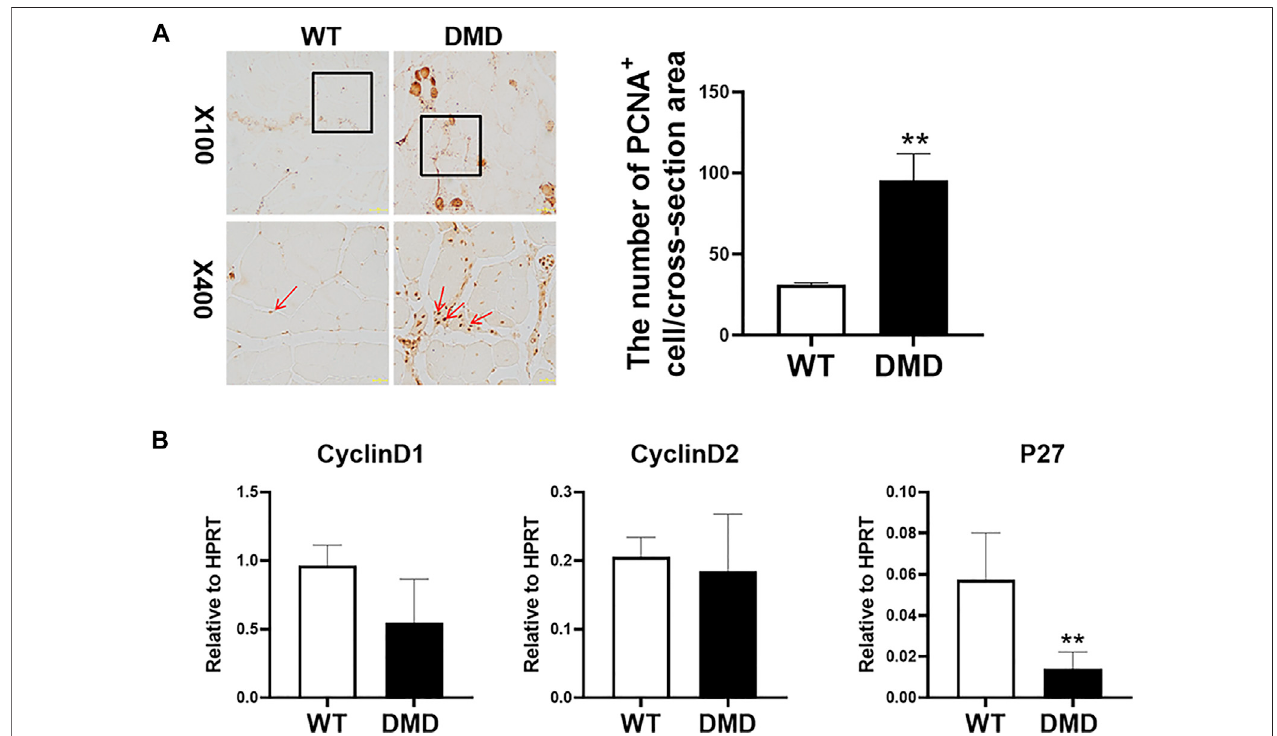
FIGURE 2 | Increase proliferation of muscle cells in tibialis anterior in DMD mice. (A) Immunohistochemical staining of mouse muscle cells was performed with the PCNA antibody. PCNA positive cells are shown as brown (red arrow). The PCNA positive cells were counted under microscope. Numbers of PCNA positive cells were demonstrated in the visual fi eld Data were presented at means ± SEM ( n = 6) with independent sample t -test. ** p < 0.01. (B) Gene expression of tibialis anterior cells in WT and DMD mice was detected by RT-PCR. Data are expressed as the mean ± SEM ( n = 6). ** p <